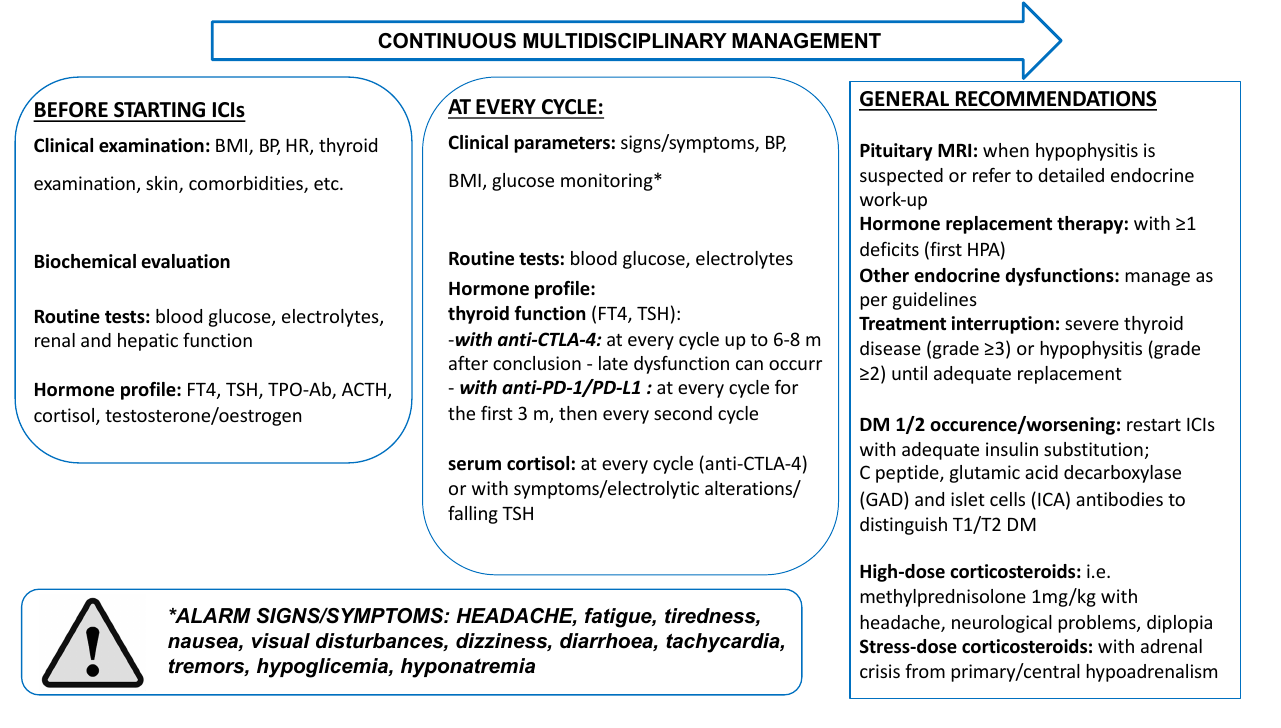
Figure 2. An updated flowchart for endocrine irAEs management, according to the most